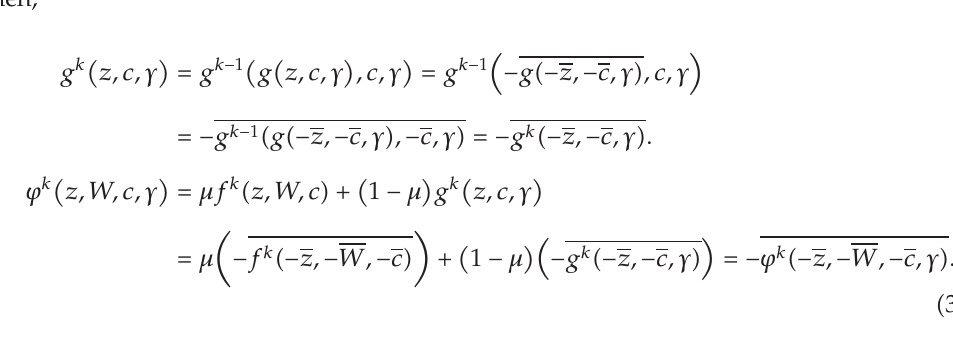
Figure 23: The generalized J sets perturbed by the composing noise when α (cid:6) 5 . 5, θ ∈ (cid:7) − π,π (cid:4) , here Figures (cid:3) a (cid:4) and (cid:3) b (cid:4) are the graphs with c (cid:6) 0 . 5 (cid:5) 0 . 5 i ; Figures (cid:3) c (cid:4) and (cid:3) d (cid:4) are the graphs with c (cid:6) 0 . 5 − 0 . 5 i .